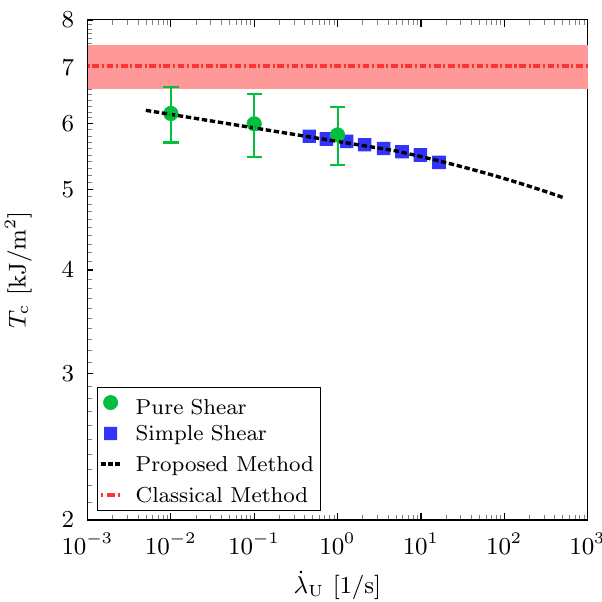
Figure 11. The relationship between the critical tearing energy and the unloading rate for pure shear and simple shear dynamic experiments using the proposed method where the dashed black line is the fitting. The red chain line represents the average tearing energy using the classical method and fill area represents the experiment scatter (error